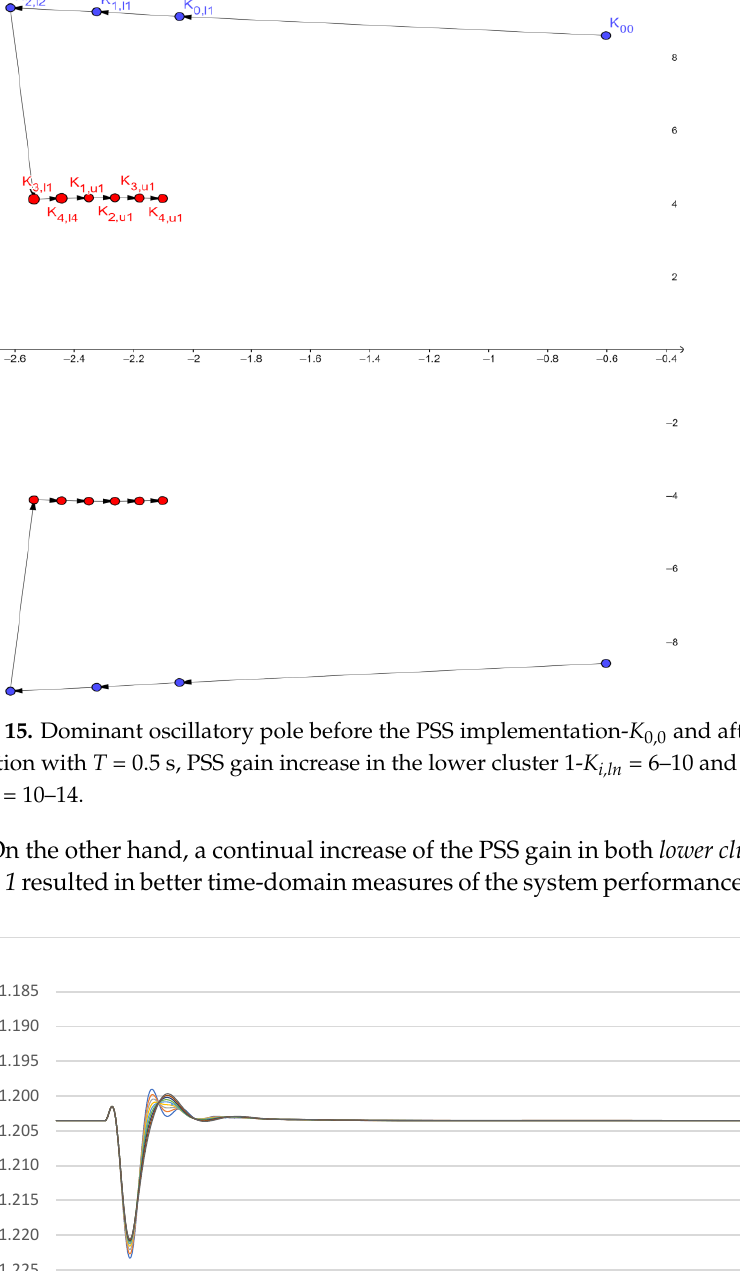
-1.230-1.225-1.220-1.215-1.210-1.205-1.200-1.195-1.190-1.185 Figure 16. Gen1 rotor angle response on a small disturbance with PSS parameters T = 0.5 s, the PSS gain increase in the lower cluster 1- K i,ln = 6 – 10 and the upper cluster 1 K i,um = 10 – 14.